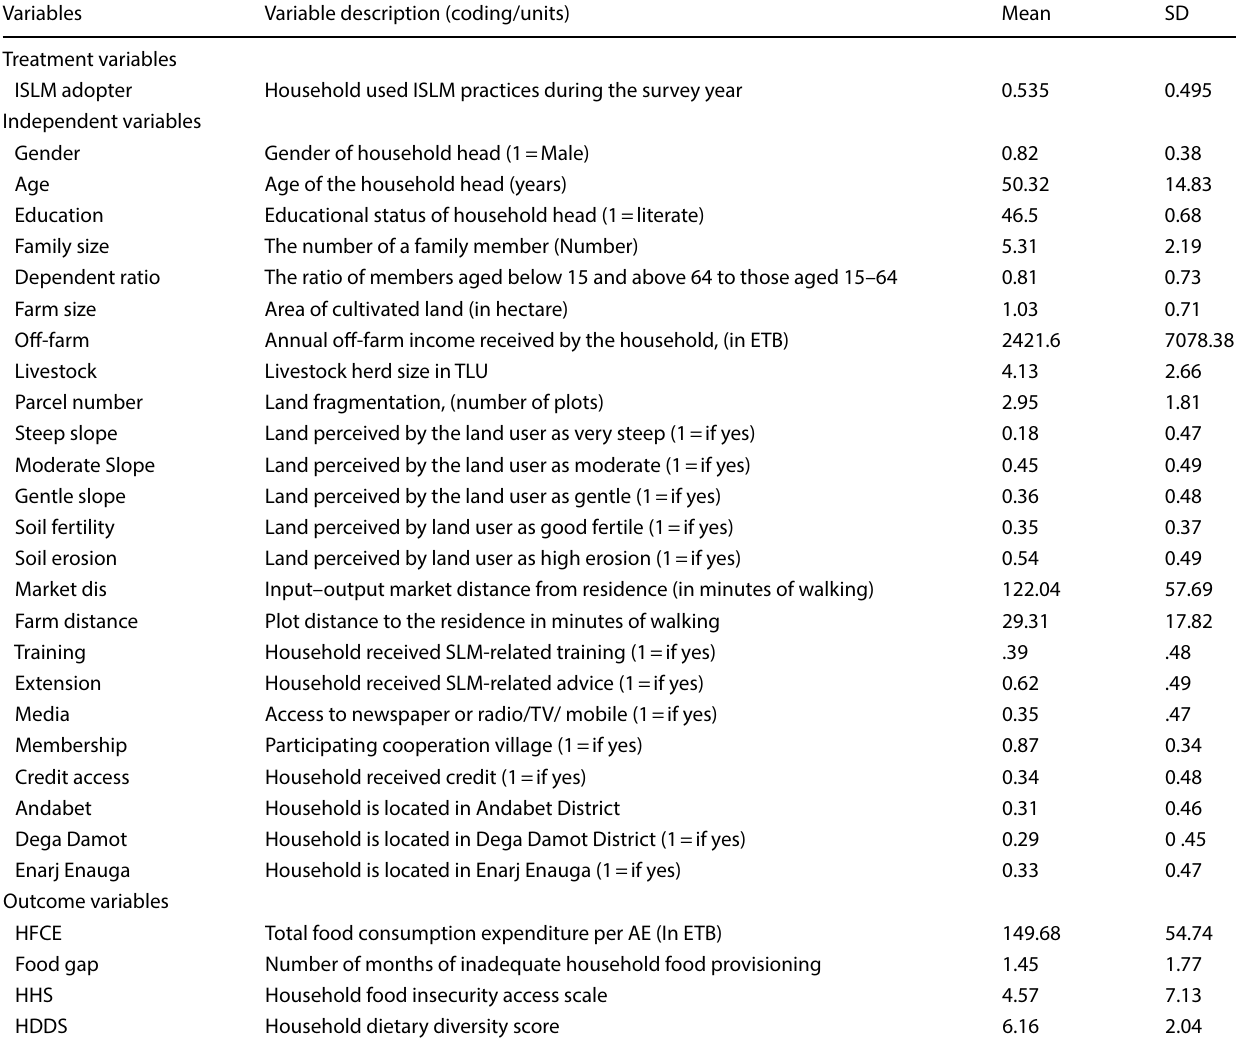
Table 2 Definitions and description of selected variables used in the regression